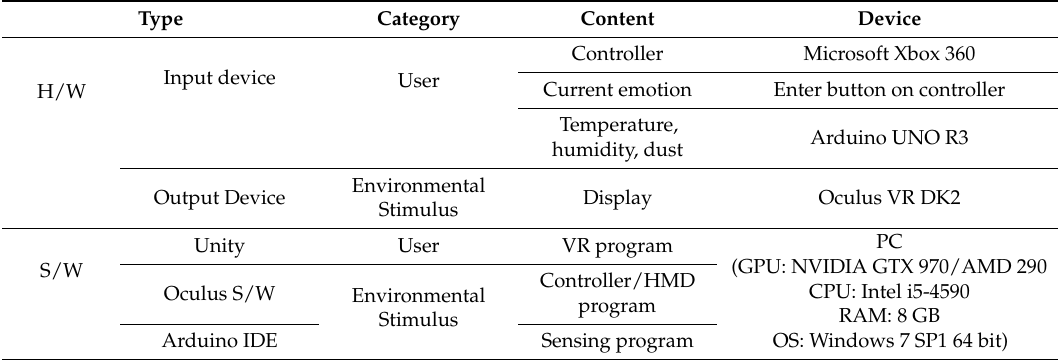
Table 4. System specifications.